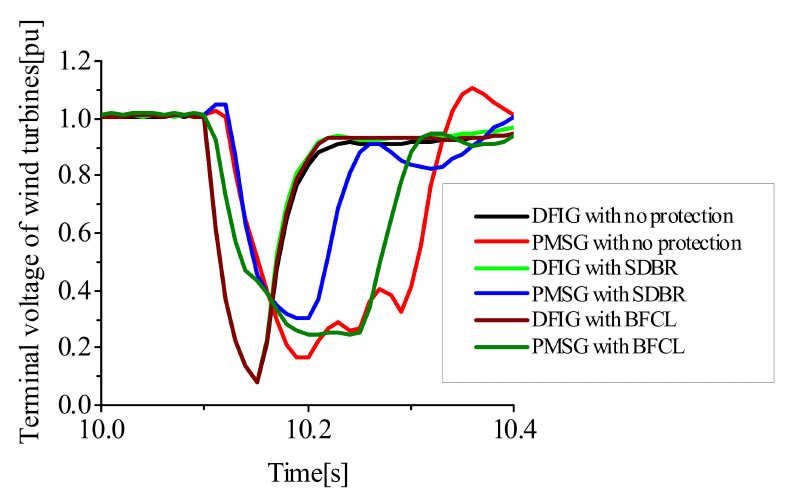
Figure 19. Terminal voltage of the wind